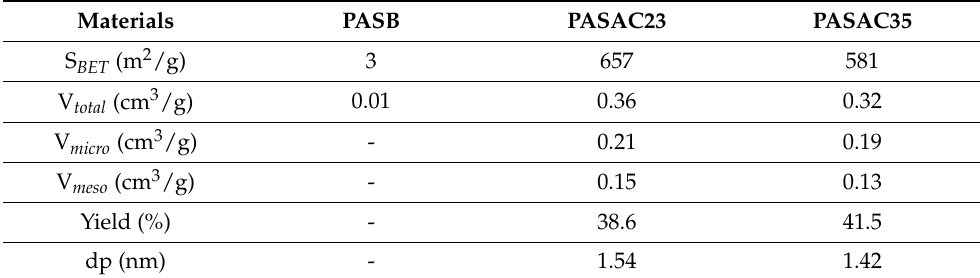
Table 3. Pore structure parameters of PASB, PASAC23, and